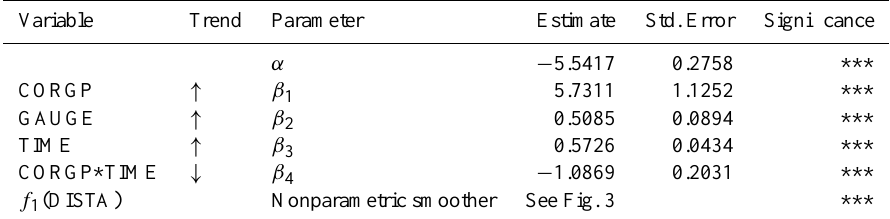
Table 5. Parameter estimates and significances for the model estimating the local relief energy (RELEN) as shown in Eq. (9). Significance levels: ***: p < 0.001, **: p < 0.01, *: p < 0.05. The variance of the random effect a in Eq. (9) is 0.1119. Trend: qualitative illustration of linear predictor variables’ significant influences. ↑ , ↓ : RELEN increases (decreases) with increasing values of the respective predictor variable.